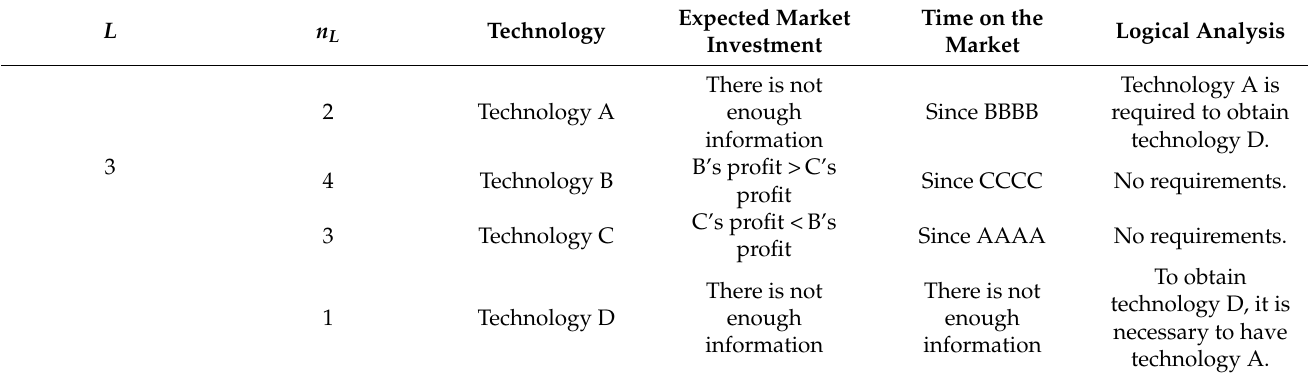
Table 3. Generic example of the assignment of n